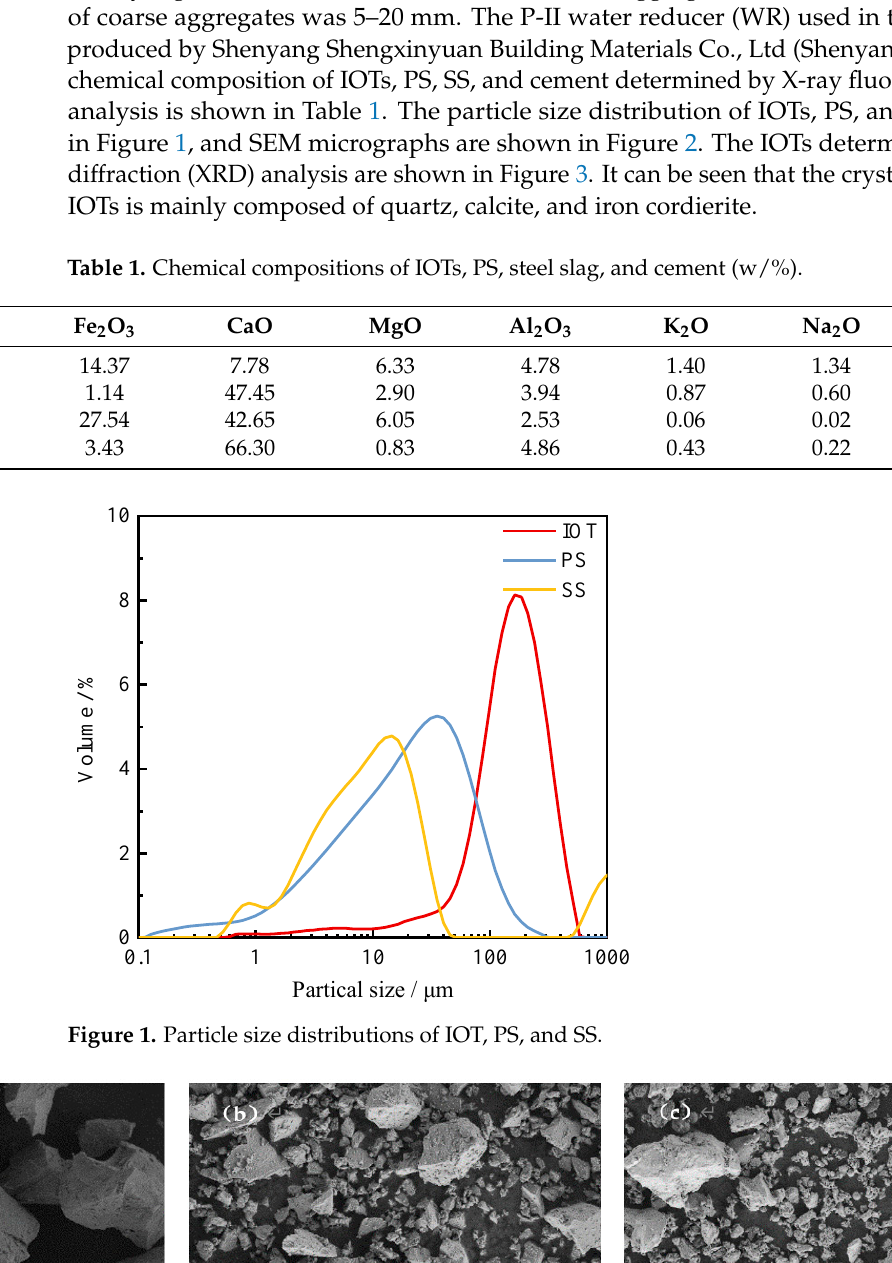
♣ calcite ♠ sekaninaite 2 θ /° ♠ Figure 3. The XRD pattern of the IOT. 2.2. Experimental Methods 2.2.1. Grinding The IOTs were dried in an oven at 105 °C. After drying, the IOTs were sieved and particles between 0.075–0.15 mm were selected for grinding to improve the crushing effi- ciency and reduce the effect of ultra-fine powders smaller than 0.075 mm on the crushing. The dried IOTs were ground in an XQM-4 laboratory ball mill (Tencan Powder , Chang- sha, China) for 1.5 h, 2 h, and 2.5 h, respectively. We used Micromeritics ASAP 2460 (Mi- cromeritics, Shanghai, China) to determine the specific surface area and pore size distri- bution of the milled iron tailings, and nitrogen was selected as the adsorbent. For degas- sing, the temperature was increased to 90 °C for 1 h at 10 °C/min and then increased to 200 °C for 4 h at 10 °C/min. After degassing, the samples were cooled to room temperature, and the samples were taken out and tested in liquid nitrogen at − 196 °C. 2.2.2. X-ray Photoelectron Spectroscopy X-ray photoelectron spectroscopy (XPS) was used to determine the surface binding energy of Al, Si, and Ca elements in IOTs at different grinding times. The test conditions were as follows: the vacuum of the chamber was 8.0–10 Pa, the excitation source was Al K-rays with energy of 1.4867 keV, and the flux energies of the full and fine spectra were 100 eV and 30 eV, respectively, in steps of 0.1 eV, with a dwell time of 40–50 ms, and the binding energy of C1s (284.8 eV) was used as the energy standard for charge correction.